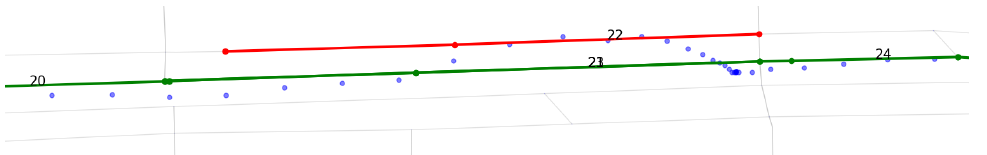
Figure 10. Model outcome for Cat-II error : identified isolated lane in Dataset 7.